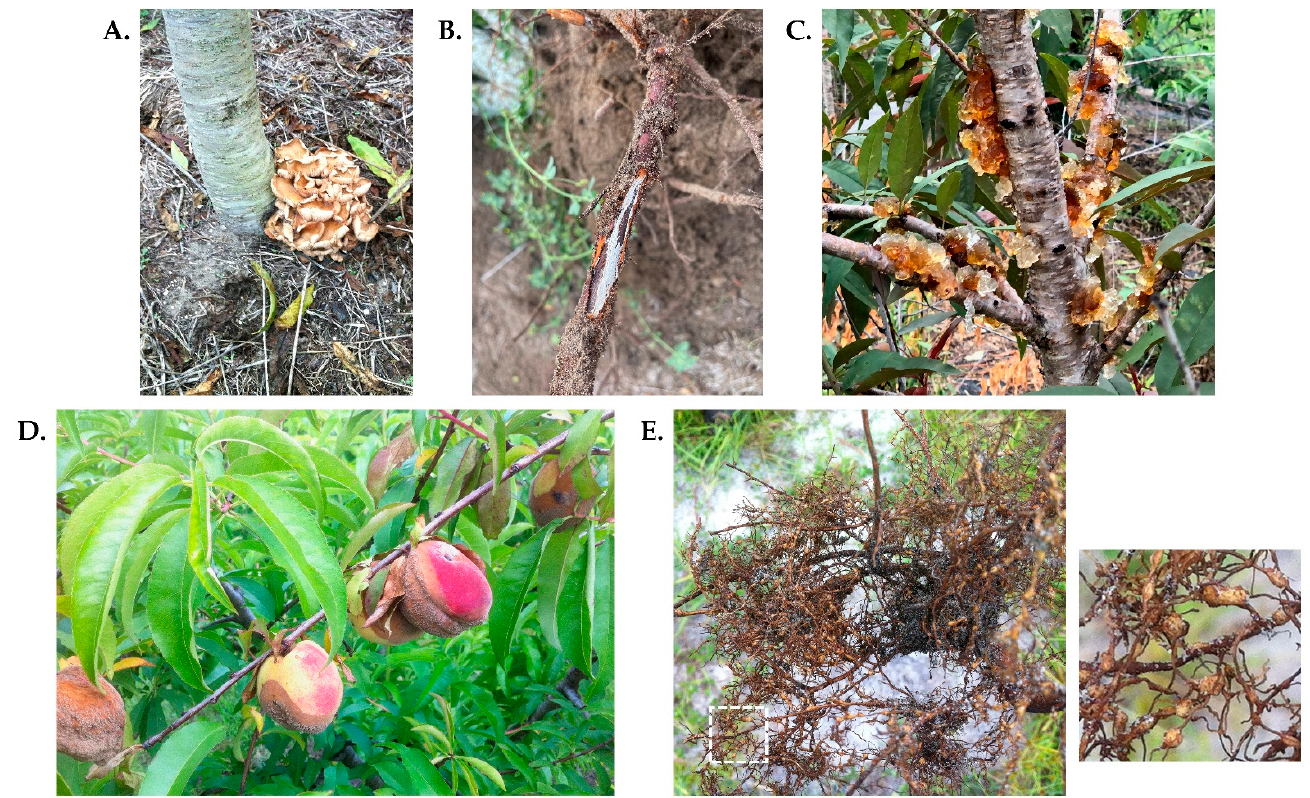
Figure 1. ( A ) Oak root rot disease in peaches caused by Desarmillaria mellea with typical fan-shaped mycelial mats at the base of the tree. ( B ) White mycelia of Desarmillaria mellea growing underneath an anchorage root bark. ( C ) Peach gummosis disease caused by Botryosphaeria dothidea in an infected tree, with limbs exuding large amounts of gum. ( D ) American brown rot disease caused by Monilinia fructicola developing on ripening fruit and foliage. ( E ) Root-knot nematode galls caused by Meloidogyne spp. in an infected young peach tree. Photos courtesy of Jose X. Chaparro.